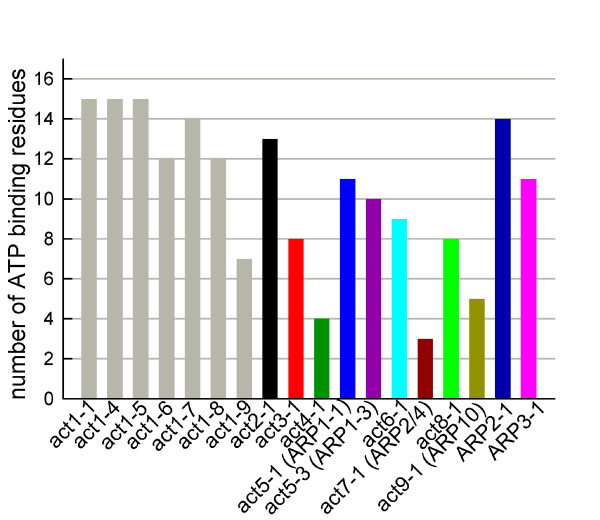
Conservation pattern of residues involved in ATP binding.Conservation pattern of 17 residues (D13, S16, G17, L18, K20, Q139, D156, D159, G160, V161, K215, G304, T305, M307, Y308, and K338) known to participate in ATP binding to actin. For subfamilies in which the conservation pattern is identical for all members, only one is shown.